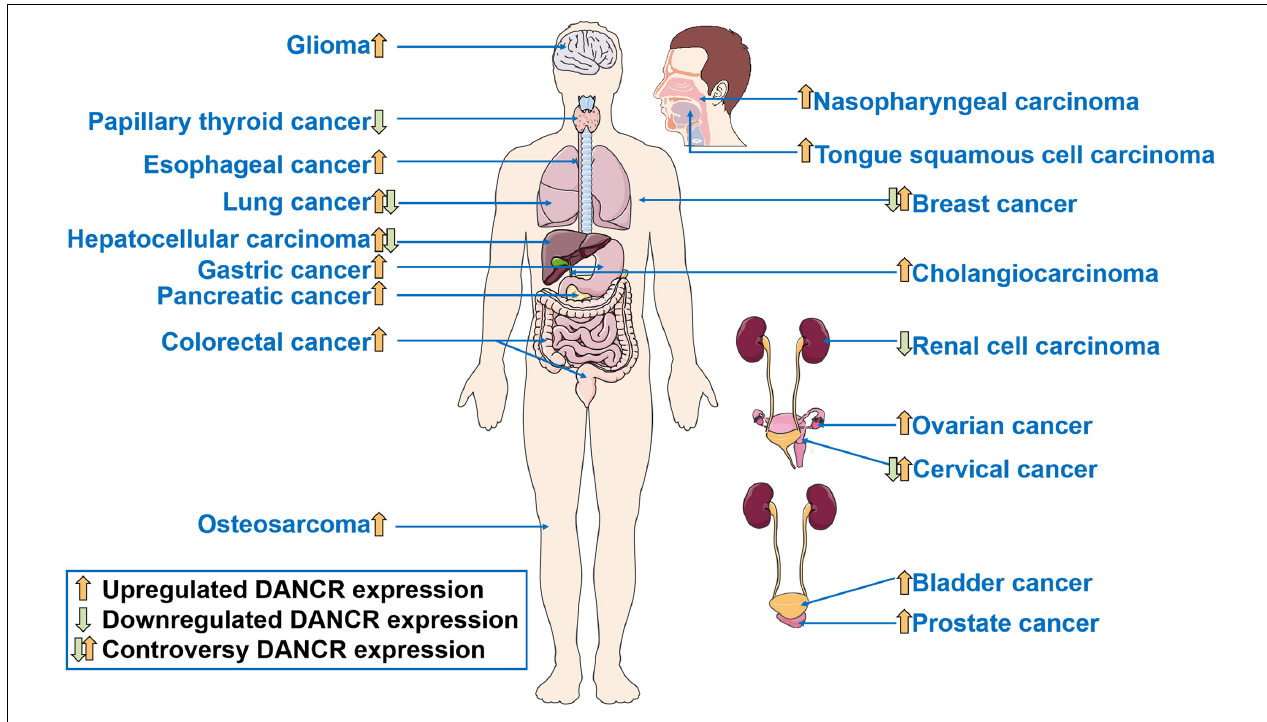
FIGURE 1 | The dysregulation of DANCR expression in human